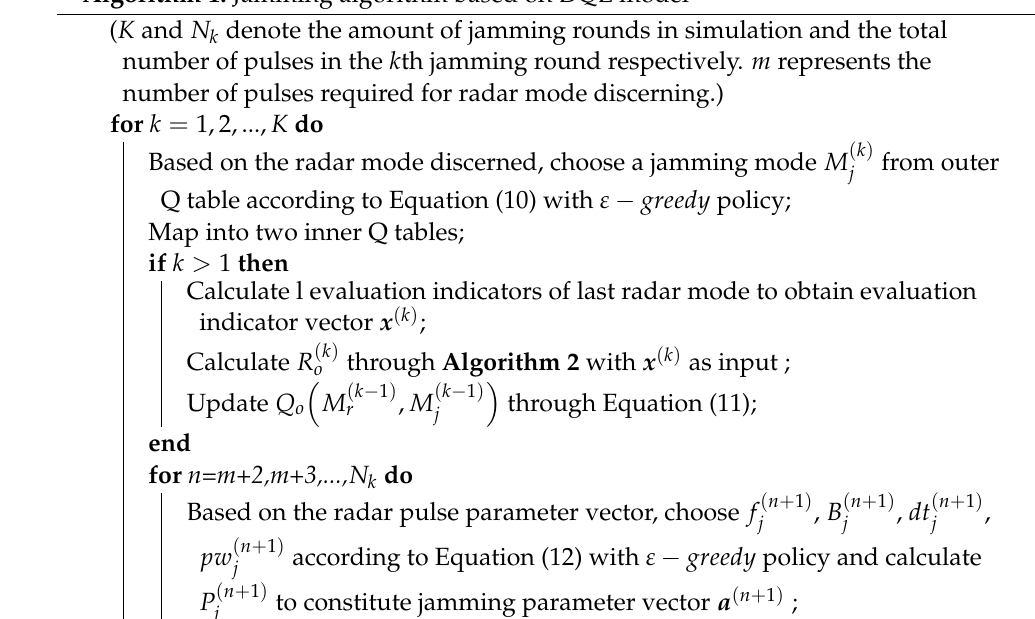
Algorithm 1: Jamming algorithm based on DQL model